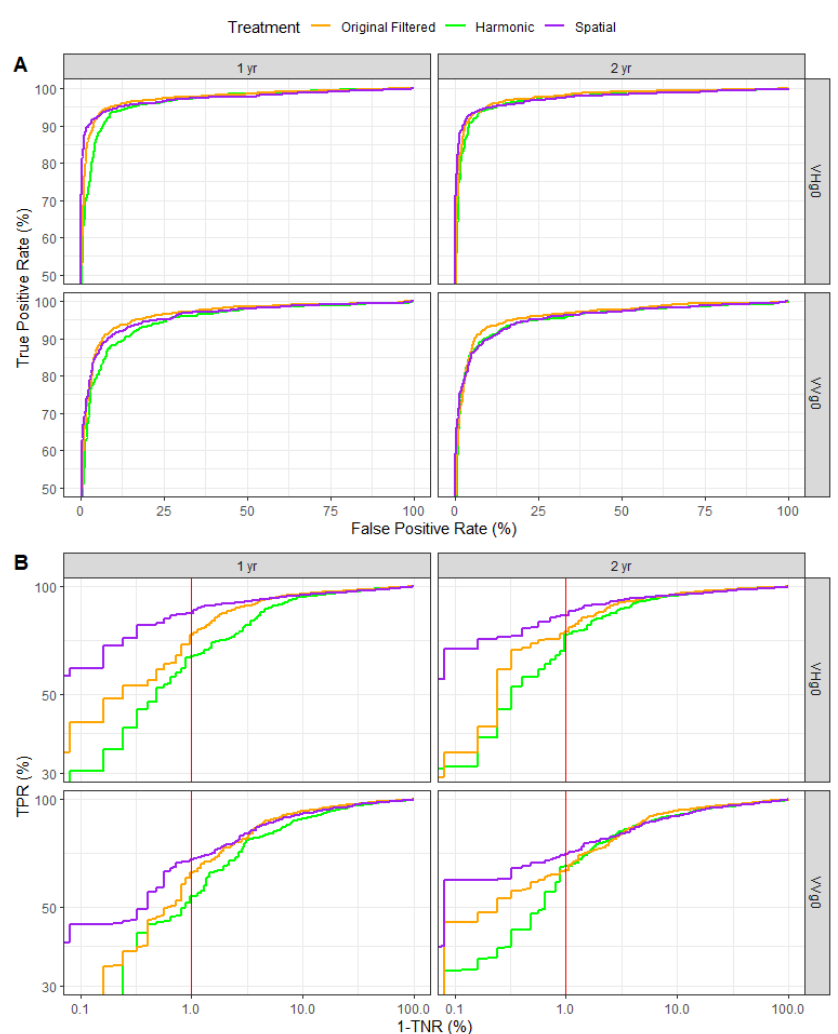
Figure 9. Receiver–Operator Characteristic (ROC) curves associated with the maximum likelihood detection procedure. ( A ) ”Classical” chart in linear scale; ( B ) detailed view using a logarithmic scale. The vertical red line indicates the optimal TNR level (1%) for an Early Warning System (EWS).